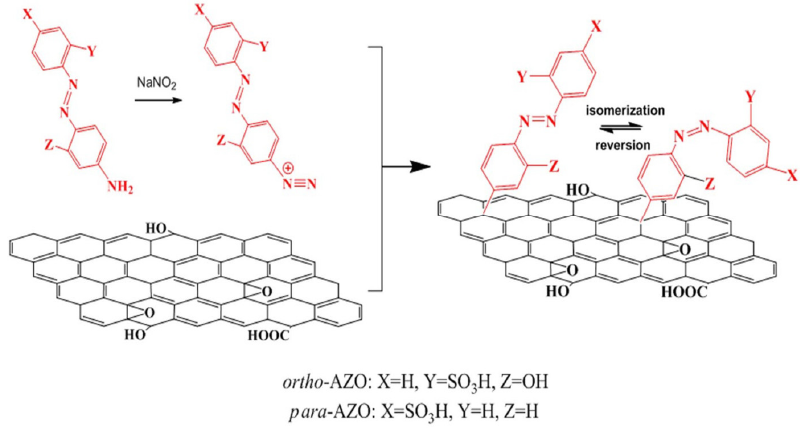
Figure 12. The synthesis route and chemical structures of RGO-para-AZO and RGO-ortho-AZO hybrids by the diazotization [105].